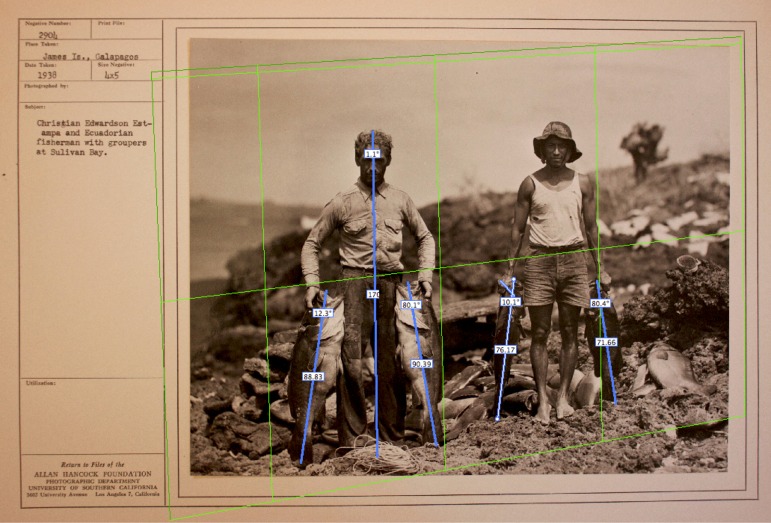
Historical photograph from 1938 showing a typical fishing trip for bacalao, with grid and measurements used in our analysis.Photograph courtesy of the University of Southern California, on behalf of USC Libraries.